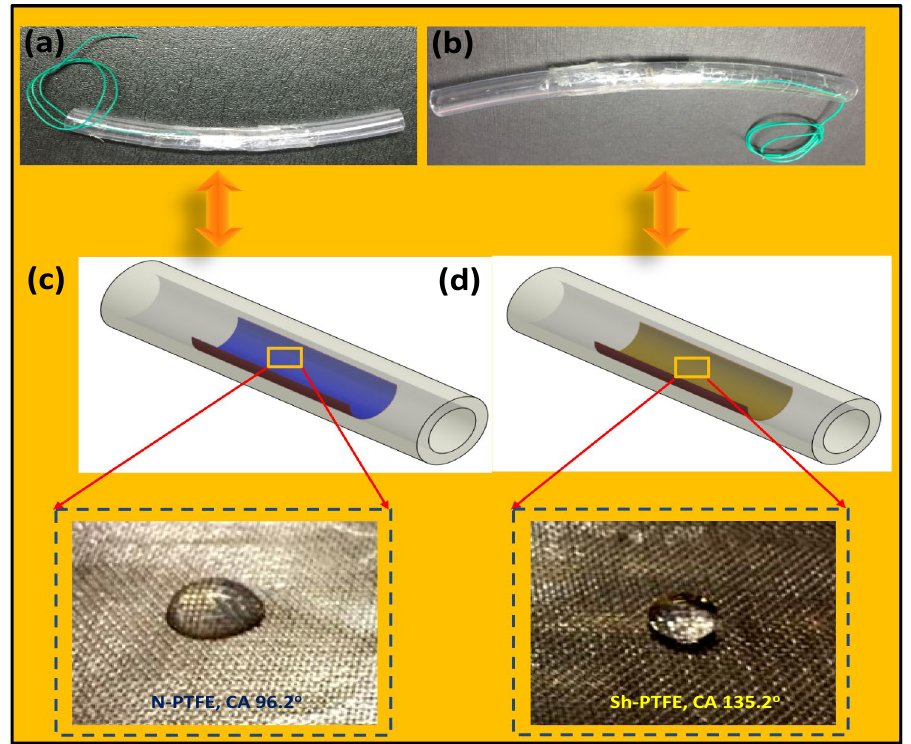
Figure 2. Digital photos of large droplets (~ 5 μl) placed on ( a ) N-TENG cell, ( b ) Sh-TENG cell, ( c ) N-PTFE (CA = 96°), ( d ) Sh-PTFE (CA = 135.2°).